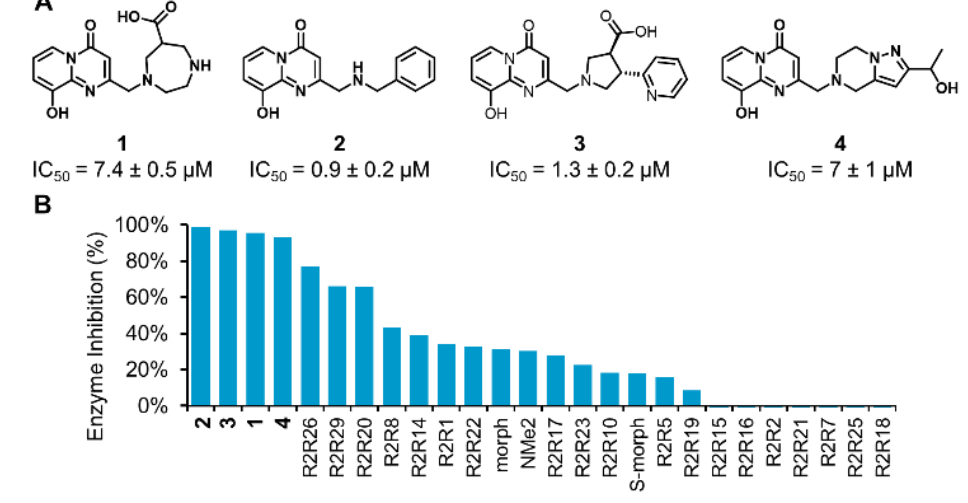
Figure 1. ( A ) Structures and IC 50 of initial lead compounds ( 1 – 4 ). Values are reported as mean ± SD, n = 3. ( B ) Screening results of the PPO sub-library, tested at 40 µM in duplicate. Data were